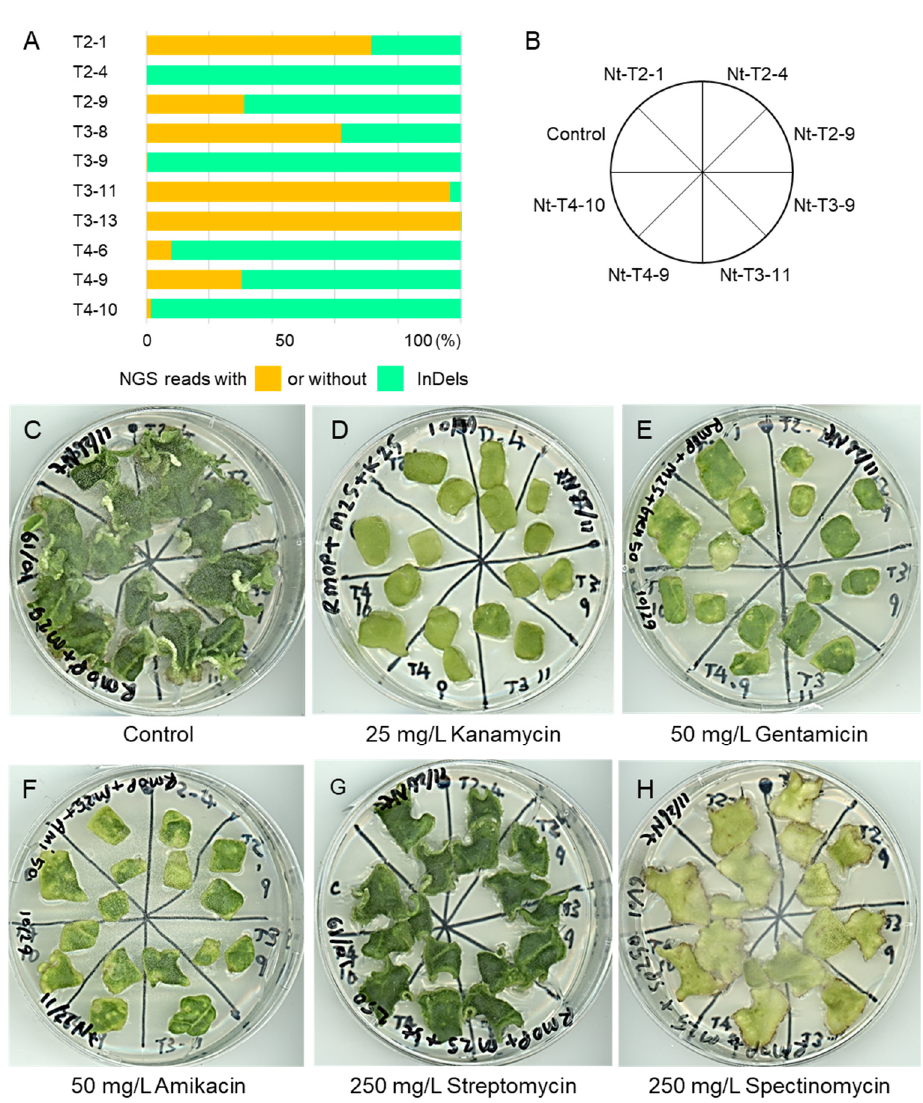
Figure 3. Evaluation of aminoglycoside antibiotic resistance in tissue culture of T 0 generation of N. tabacum . ( A ) indicates the ratio of amplicon sequencing reads with and without InDels at the target sites in selected transgenic lines. Resistance of selected transgenic lines to aminoglycoside antibiotics was evaluated by shoot formation capacity of the leaf pieces from non ‐ transformed plants (Control) and some selected T 0 transgenic plants placed on the test media ( C – H ) as shown in ( B ). The test media were an RMOP medium containing 25 mg/L meropenem alone (C; control plate without aminoglycosides), and those containing 25 mg/L kanamycin ( D ), 50 mg/L gentamycin (E ), 50 mg/L amikacin ( F ), 250 mg/L streptomycin ( G ), or 250 mg/L spectinomycin ( H ) in combination with 25 mg/L meropenem.